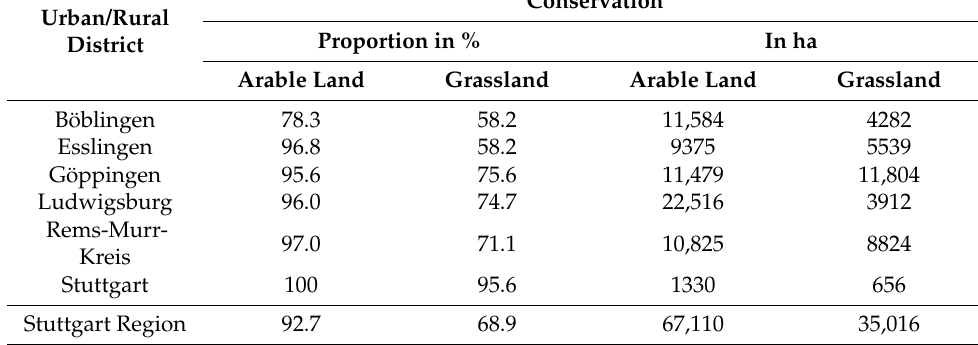
Table 7. Proportion of arable land and grassland in % and in ha that is suitable for the implementation of PIC from the perspective of nature conservation.